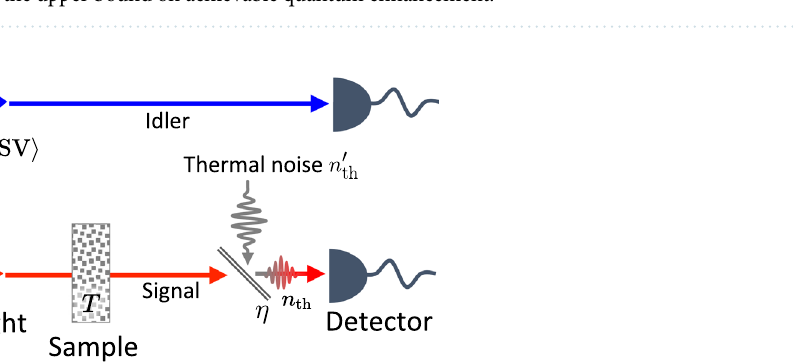
opt Figure 4. Top row: R κ of the measurement schemes in their respective regions of dominance. Bottom row: R QFI , illustrating the upper bound on achievable quantum enhancement.